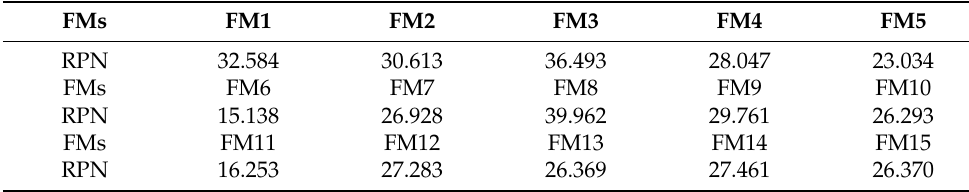
Table 8. The CIS numerical scales for different DM k